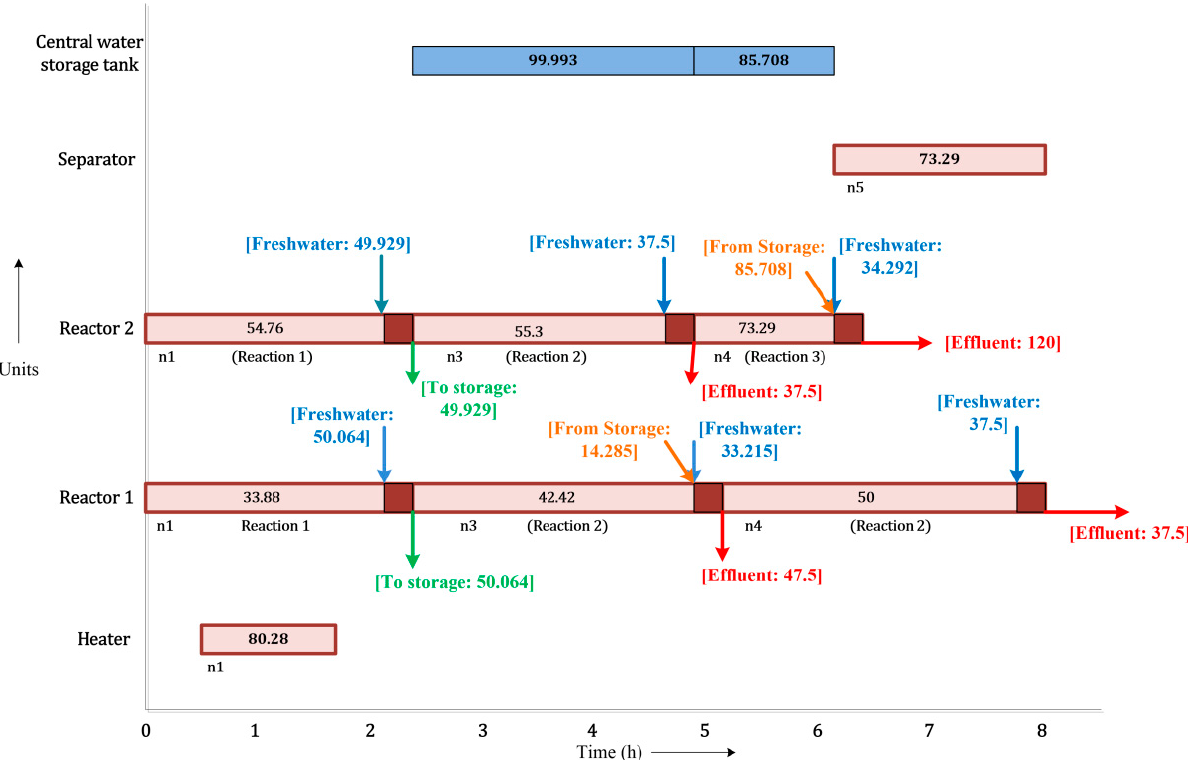
Figure 9. Gantt chart for the simultaneous approach with water storage tank for case study 1.